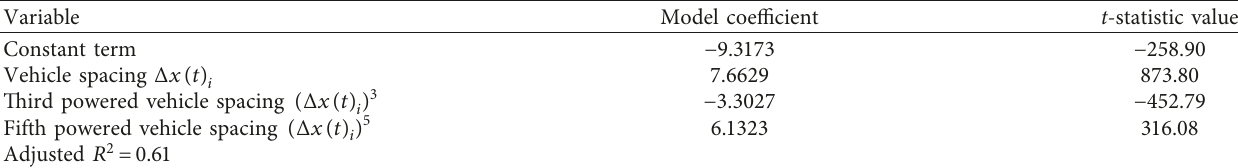
Table 5: Calibrated coefficients of the Taylor expansion approximation form of the Helbing-Tilch model.